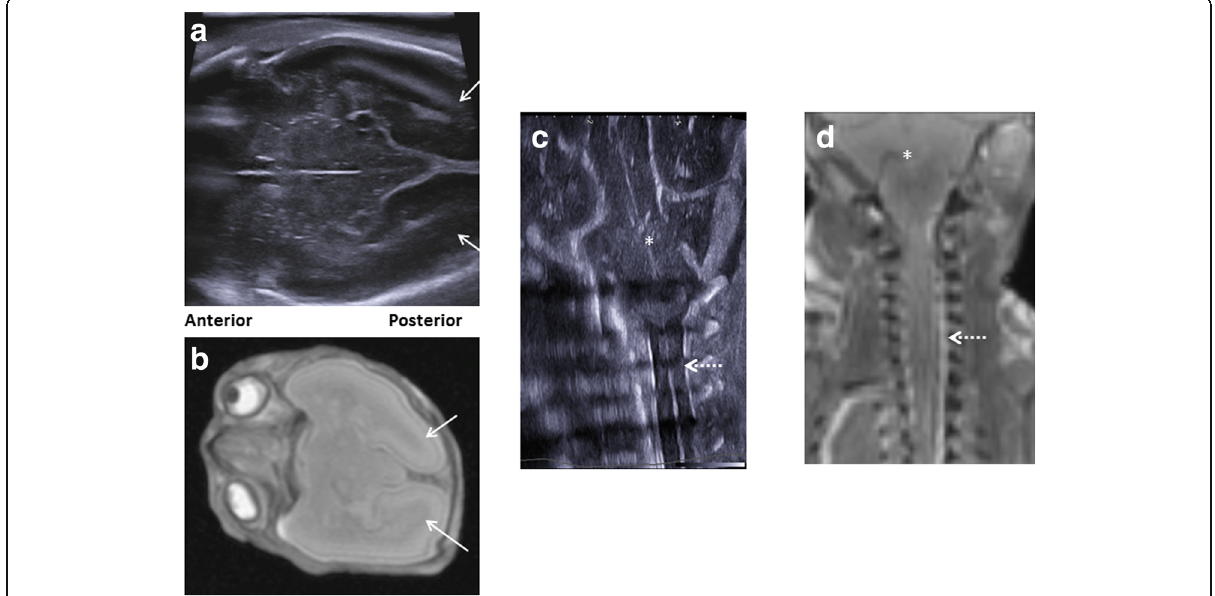
Fig. 4 Paired postmortem ultrasound and T2-weighted MRI imaging at 1.5 T are shown in this 20-week gestation foetus, 4 days after death (same case as Fig. 3). The inclusion of additional sonographic views via the left sphenoid fontanelle ( a ) provides clear images of the midbrain and occipital lobes (white arrows), as the comparison with similar view on MRI ( b ) demonstrates. The left trans-mastoid view of the brain at ultrasound ( c ) shows clearly the cerebellum (asterisk) and upper cervical spinal canal (dotted white arrow), comparable in detail as the matched T2-weighted postmortem MRI ( d